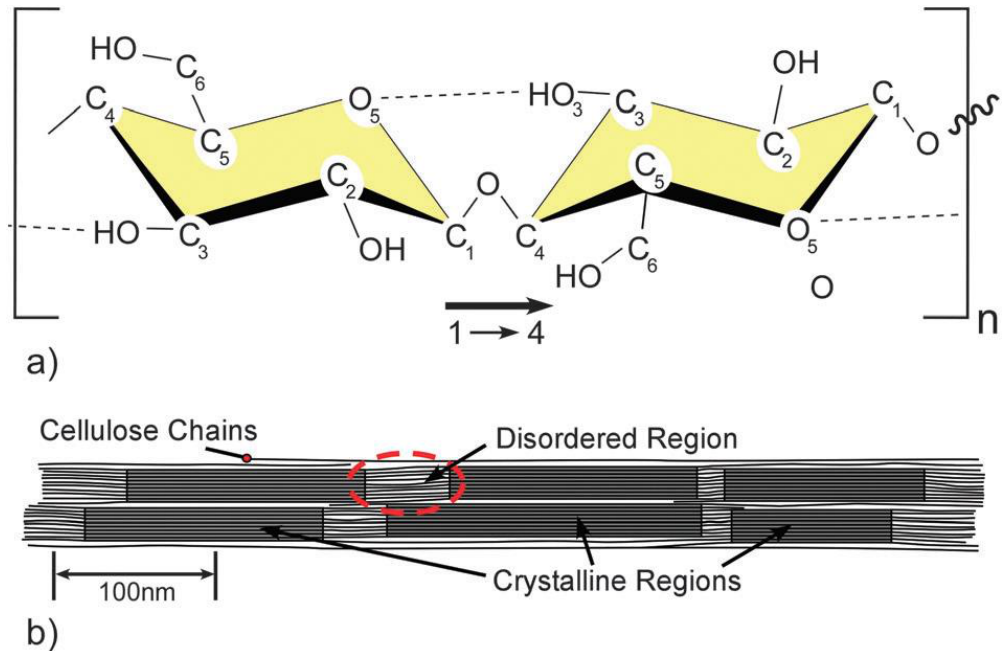
Figure 12. ( a ) Single cellulose chain of two anhydroglucose units (AGUs), showing the directionality of the 1–4 linkage and intra-chain H-bonding (dotted line), ( b ) idealized cellulose microfibril showing one of the suggested configurations of the crystalline and amorphous regions, adapted from [115], with permission from RCS, 2011.